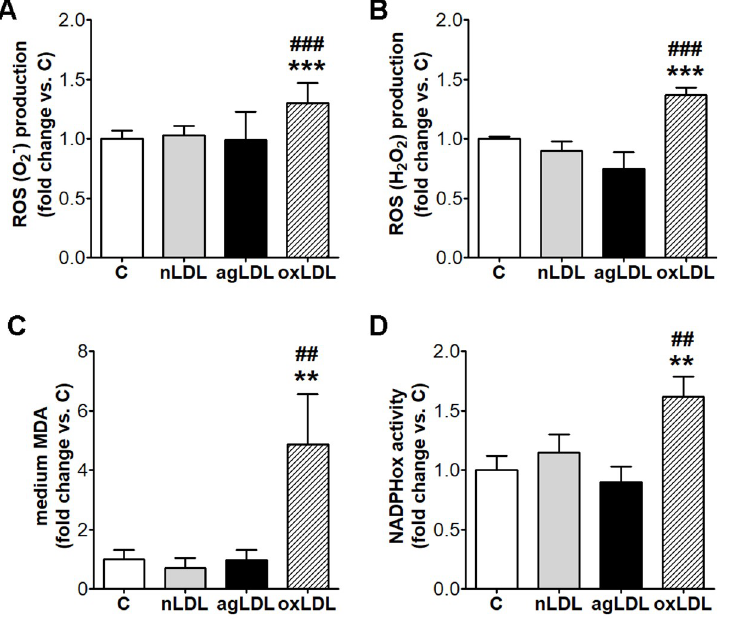
Fig 4. AgLDL do not induce oxidative stress in THP-1 macrophages. Cells were exposed for 24 h to 100 μ g/ml aggregated (agLDL), oxidized LDL (oxLDL) or native LDL (nLDL). Cells incubated in the same conditions without LDL were considered control cells (C). Intracellular levels of superoxide (O 2- ) (n = 6) (A) and of hydrogen peroxide (H 2 O 2 ) (n = 4) (B) assessed using dihydroethidium (DHE) and 2’,7’-dichlorofluorescein diacetate (DCFH-DA), respectively, and expressed as relative fluorescence units per total cell protein. (C) Lipid peroxides levels in the culture media assessed as TBARS by UHPLC and expressed as malondialdehyde (MDA) pmoles/ml (n = 5). (D) NADPH oxidase (NADPHox) activity assessed using a lucigenin-enhanced chemiluminescence assay and expressed as relative luminescence units per total cell protein (n = 4). All data are expressed as fold change versus C and presented as mean ± SD. �� p < 0.01, ��� p < 0.001 vs. C; ## p < 0.01, ### p < 0.001 vs.